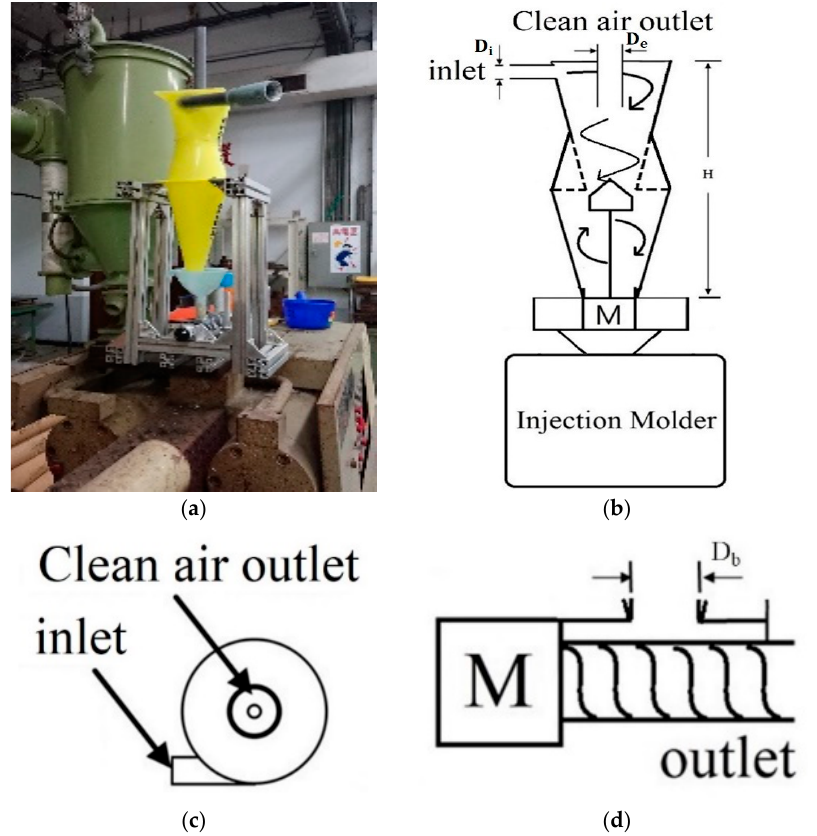
Figure 6. Cyclone mixing: ( a ) Cyclone mixer. ( b ) Cyclone mixer structure diagram. ( c ) Top view of feed inlet. ( d ) Side view of motor.